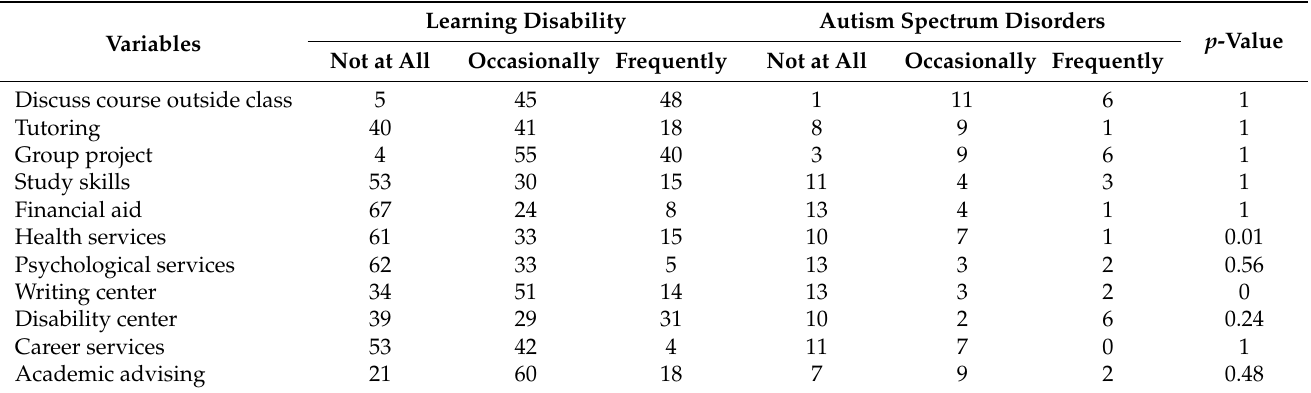
Table 5. Number of students with learning disabilities and autism spectrum disorders receiving support services first-year of